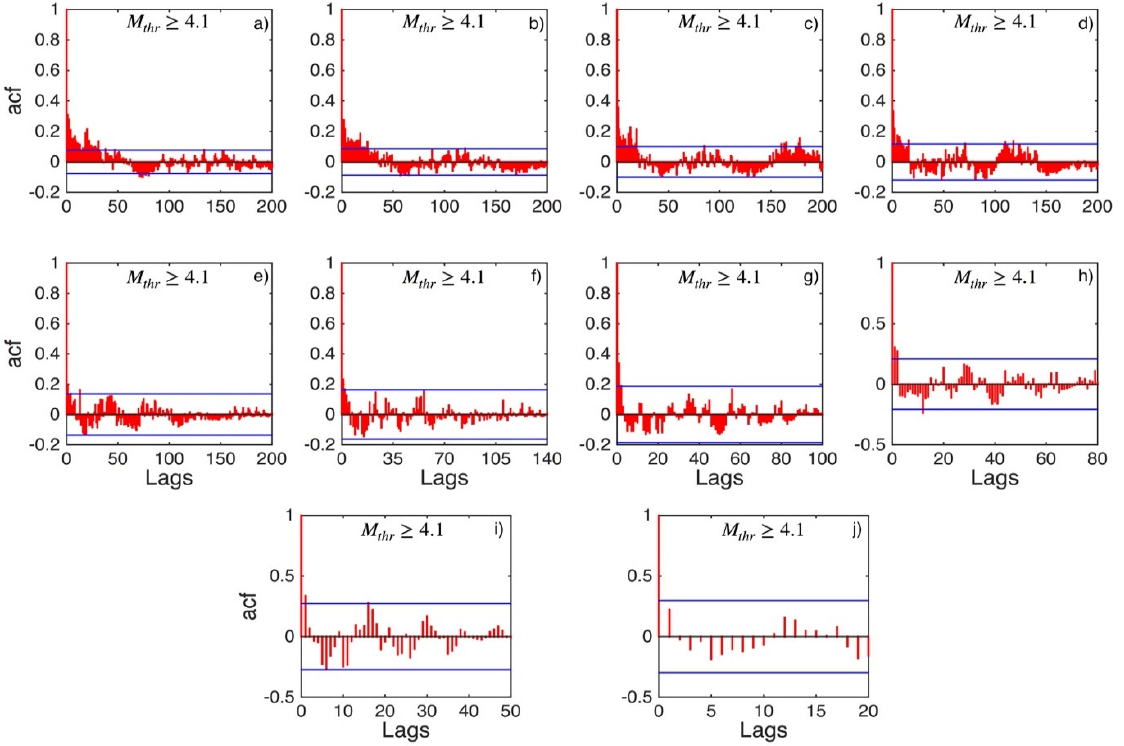
Figure A18. Statistics of Ljung–Box Q-test (blue lines) and the critical values for the X 2 distribution (red lines) for Corinth Gulf (sub-area 7) for magnitude thresholds ( M thr ) varying from 4.1 to 4.9 (subplots a – i ).